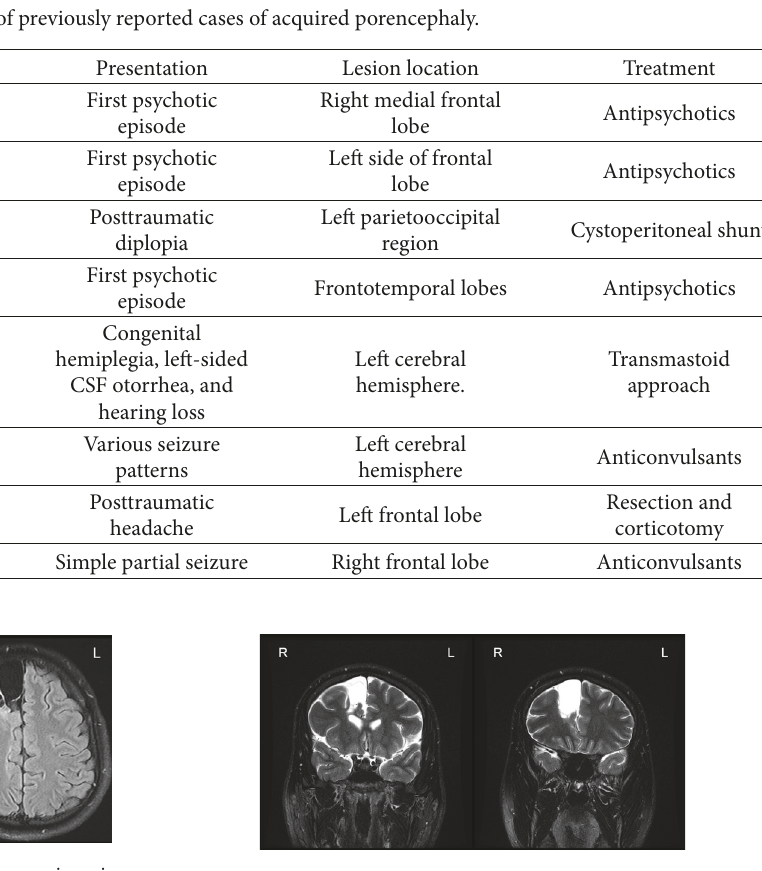
Figure 2: A coronal T2 fat-saturated image demonstrates extra- axial T2 signal hyperintensity of theright frontal region, which com- municated with the subarachnoid space (anterior interhemispheric fissure) but had no communication with the ventricular